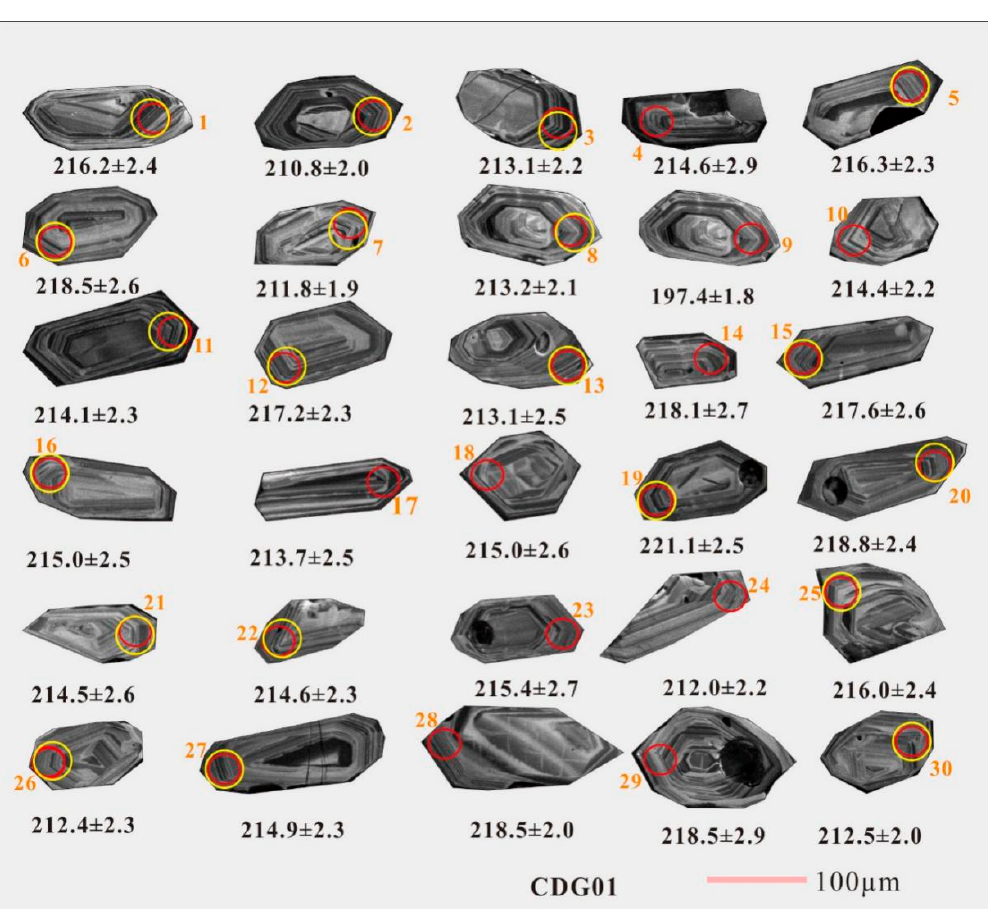
Figure 3 . Cathodoluminescence (CL) images of zircons from the Changdagou granodiorite porphyry (sample CDG-01). The larger yellow circles represent locations of Hf isotopic analyses, whereas the smaller red circles indicate spots of LA-ICP-MS U-Pb dating. LA-ICP-MS = laser ablation-inductively coupled plasma-mass spectrometry.